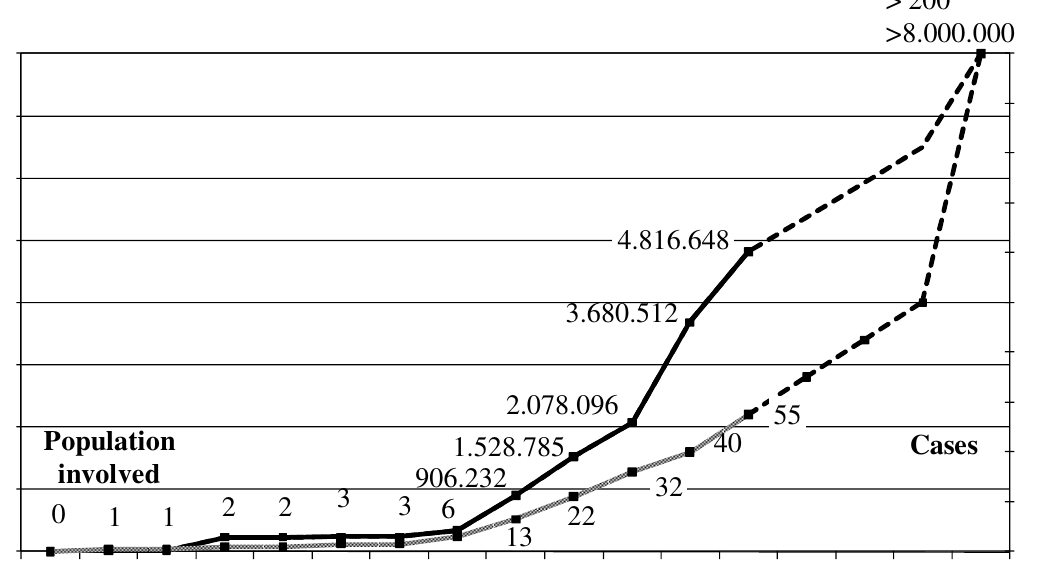
Source: Sintomer et al.,